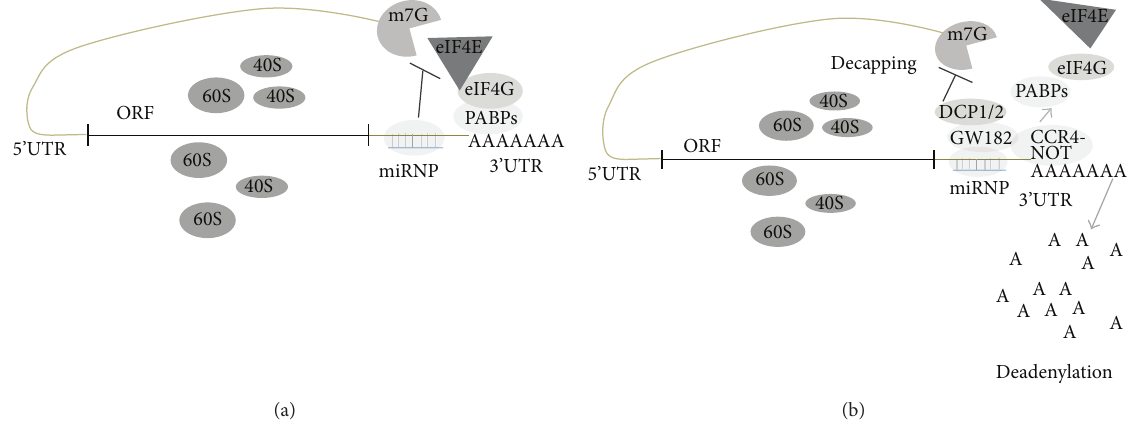
Figure 2: miRNA mediated translation repression. (a) At initiation stage the miRNP (miRNA ribonucleoprotein complex) impairs the recognition of cap by eIF4E there by inhibiting the recruitment of ribosomal subunits onto the mRNA. (b) miRNA mediated degradation of mRNA by deadenylation of 3 󸀠 − 5 󸀠 exonuclease after recruiting CCR4-NOT to the polyadenylation site where GW182 is required to bind to miRNPs. Replacement of cap by decapping enzymes DCP1/2 hampers the translation